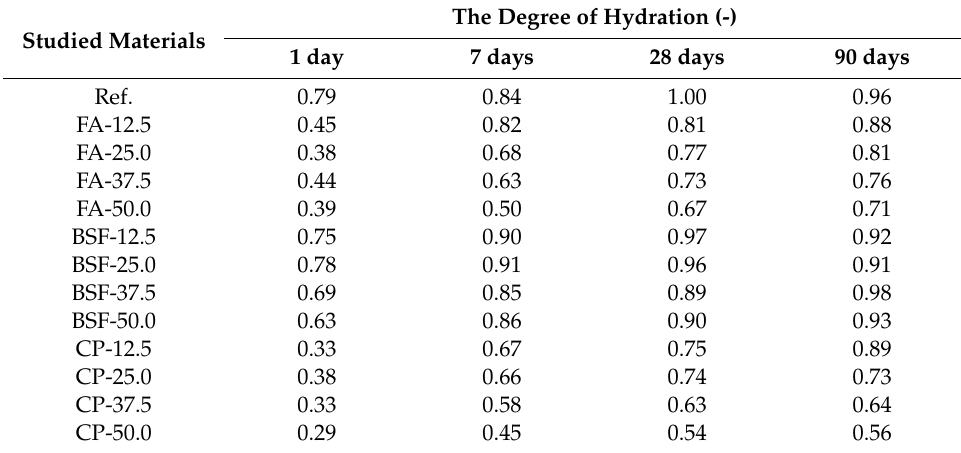
Table 6. The degree of hydration (-) of studied materials in time with correction in terms of equivalent binder mass.